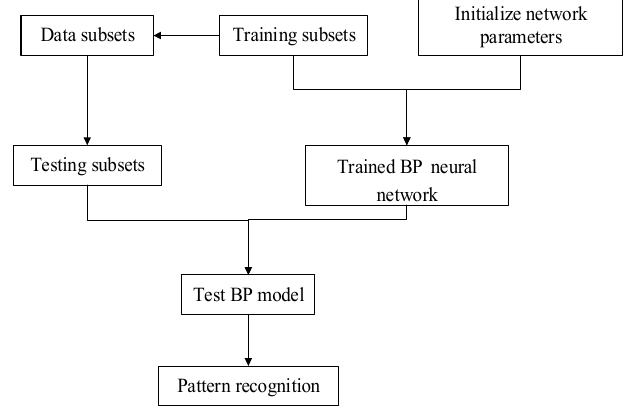
Figure 5. Flow chart of back propagation neural network training.